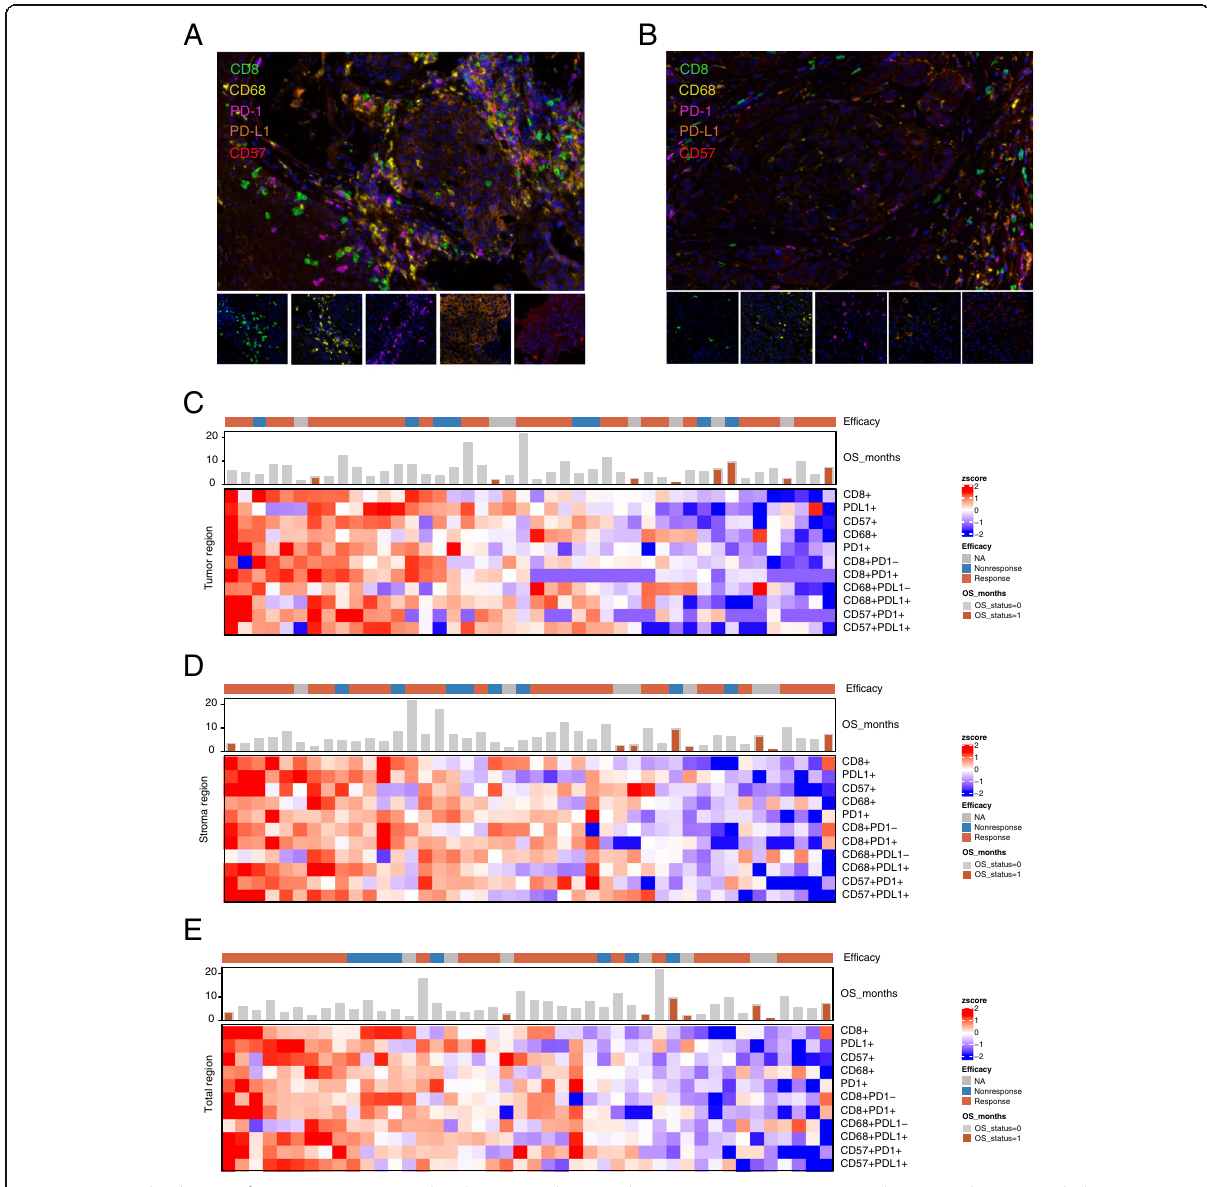
Fig. 3 Immune landscape of HNSC patients treated with immunotherapy. The mIHC images represent ( A ) the group that responded to immunotherapy and ( B ) the group that did not respond to immunotherapy. The percentages of differentially expressed cells were log- transformed and z-score standardized. Heatmaps of immune cell infiltration in the ( C ) tumor region, ( D ) stroma region and ( E ) total region. The value in the lower left part of the diagonal in the table represents the correlation coefficient (spearman) of the expression percentage of each marker positive cell subgroup (r value): r > 0, positive correlation; r < 0, negative correlation. Specifically, a certain range of the r value indicates high correlation (0.8 – 1.0), strong correlation (0.6 – 0.8), moderate correlation (0.4 – 0.6), weak correlation (0.2 – 0.4), and very weak correlation or non- correlation (0.0 – 0.2). The r value was replaced by the pink circle in the upper right part of diagonal in the table. Pink and blue represent positive and negative correlations, respectively, while the asterisk at the top right represents the P value: * P < 0.05, ** P < 0.01, and *** P <